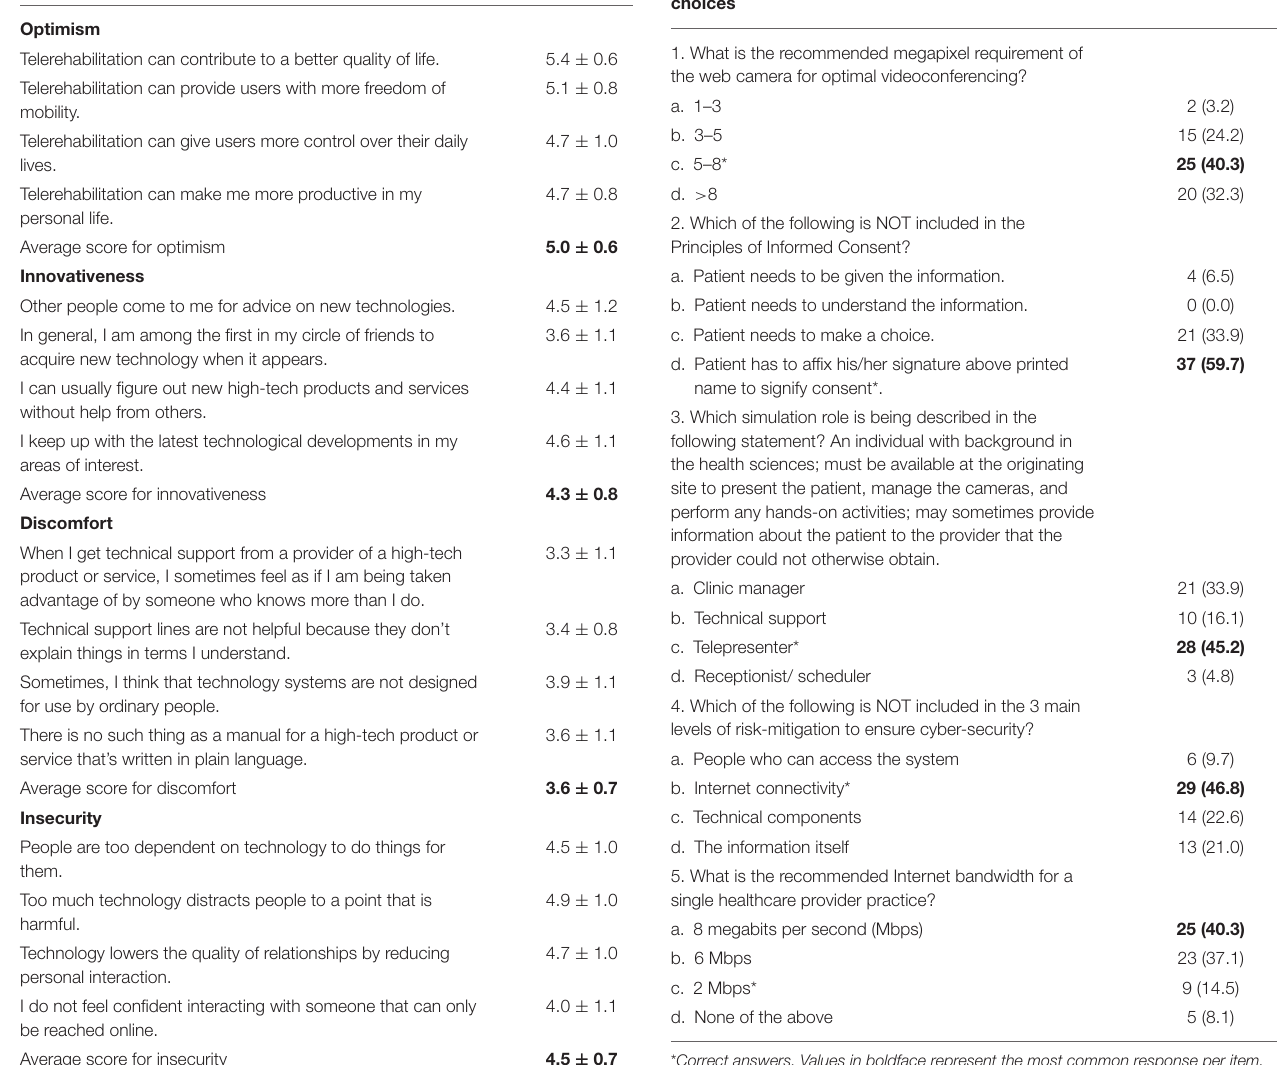
TABLE 2 | Telerehabilitation readiness of the respondents ( N = 62) based on the modified Technological Readiness Index (TRI) version 2.0*. Items per TRI dimension Mean ± SD † Optimism Telerehabilitation can contribute to a better quality of life.